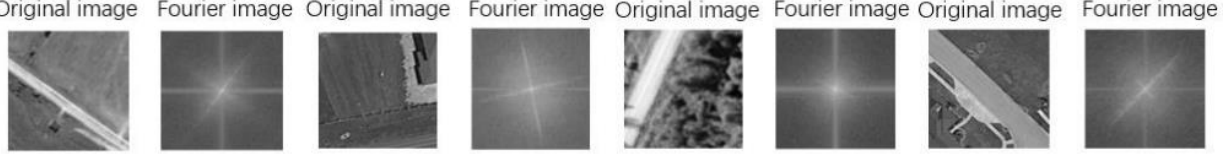
Figure 1. Part of the remote sensing images and their transformation into a spectrogram of the two-dimensional visualization in the frequency domain.